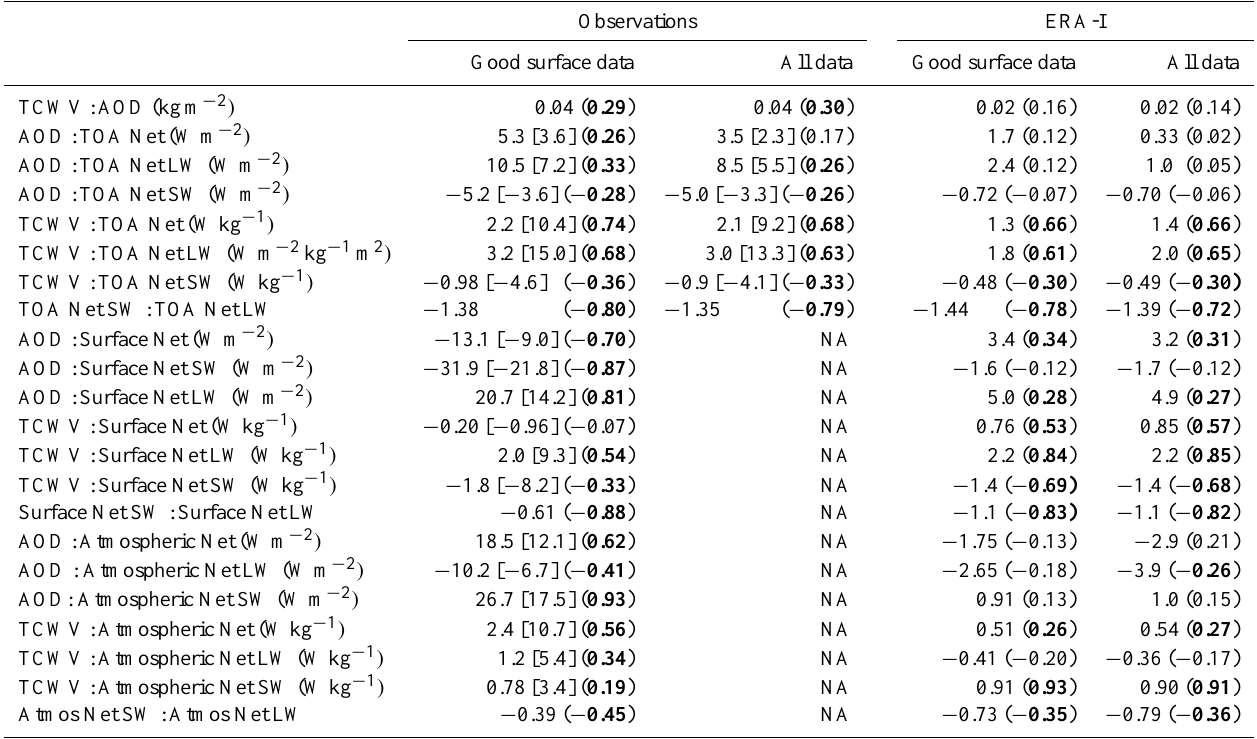
Table 1. Gradients of best-fit straight lines (i.e. regression coefficients) for listed relationships, values in [ ] are normalised by standard deviation of TCWV or AOD. Values in ( ) are correlation coefficients (bold values are significant at 90% level). For ERA-I observed AODs are used. Standard deviation in TCWV in ERA-I = 4.7kgm − 2 (4.5 for “All data”). For observations 4.7kgm − 2 (4.4 for “All data”). Standard deviation in AOD for observations is 0.68 (0.65 in “All